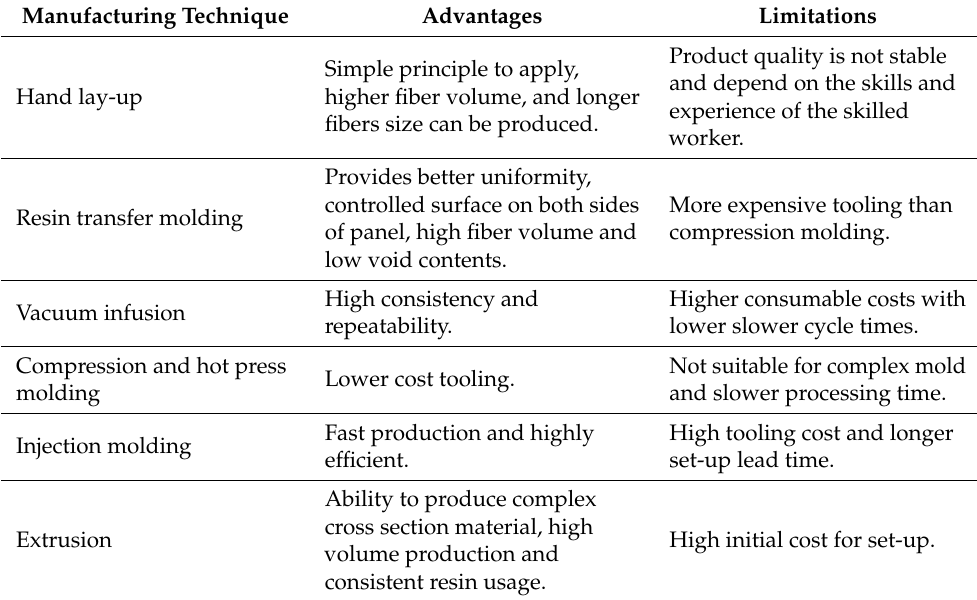
Table 5. Advantages and limitations of polymer composite manufacturing